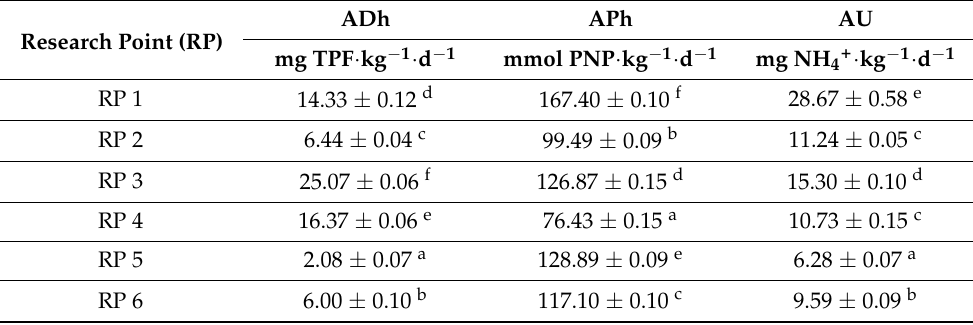
Table 7. Soil enzymatic activity.